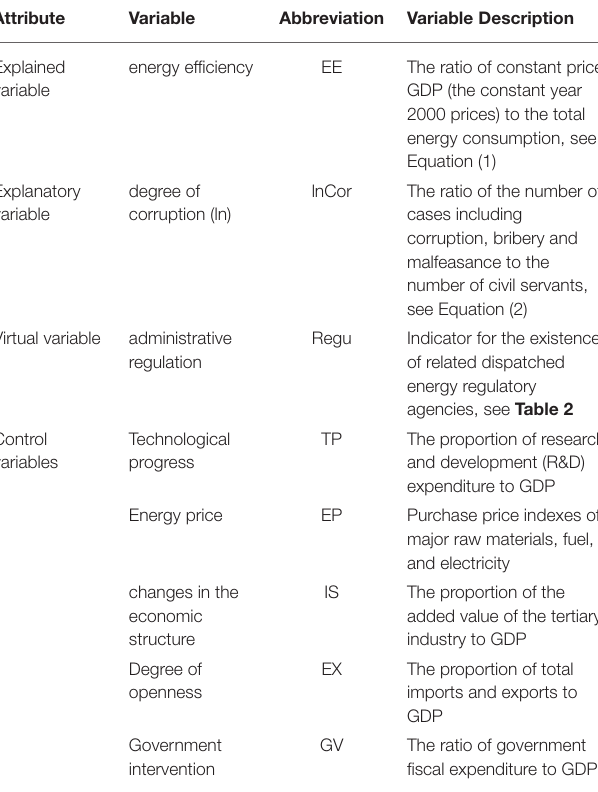
TABLE 2 | Year of establishment of local electricity dispatched agencies. Level